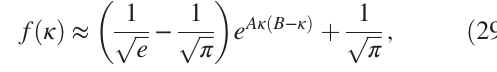
where A ¼ 6 . 1125 × 10 − 2 and B ¼ − 19 . 8135 are two dimensionless fitting parameters. The error from this approximation is below 0.014% for any κ .